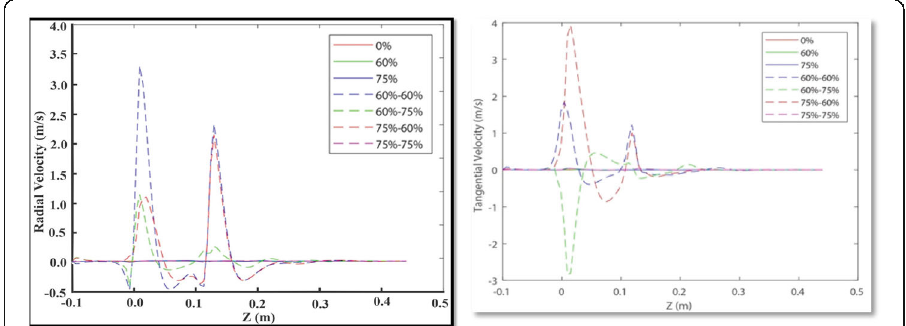
Fig. 8 Effect on radial velocity (× 10 − 2 , left) and tangential velocity (× 10 − 2 ,